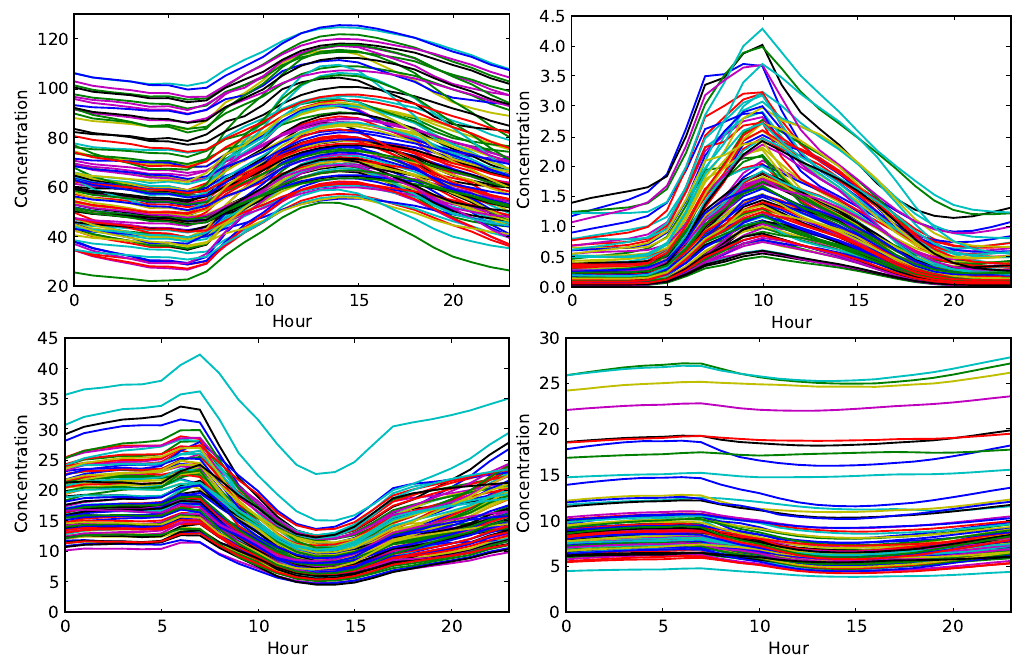
Fig. 11. Daily profile for ozone ( network 3 ), NO, NO 2 ( network 3 ) and SO 2 . The profile is computed at observation stations for O 3 and NO 2 . It is computed with all computed values (that is, from all grid cells) for NO and SO 2